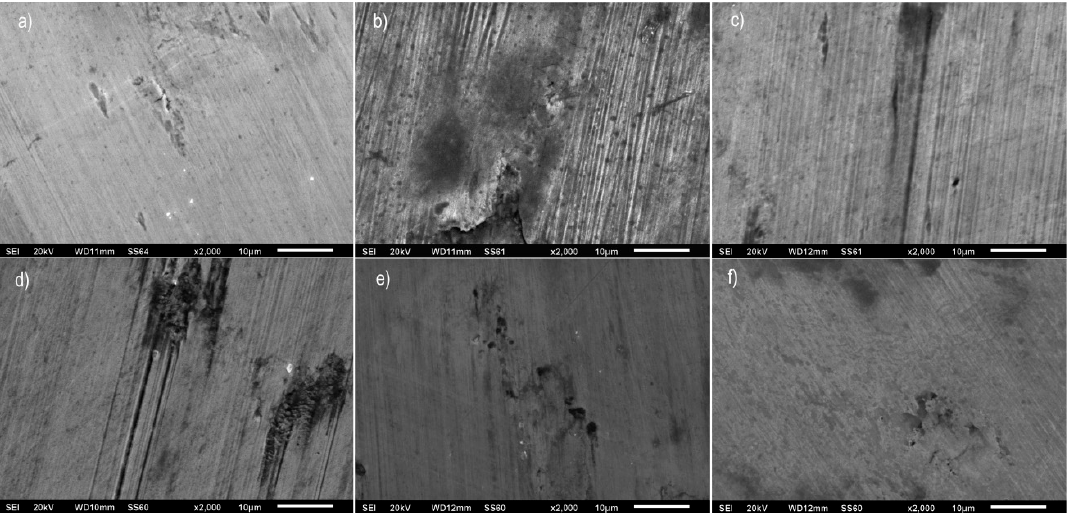
Figure 8. Abrasive wear in: ( a ) 0B-HT 12 km, ( b ) 0.06B-AC 12 km, ( c ) 0.25B-AC 12 km, ( d ) 0.5B-AC 4 km, ( e ) 1B-AC 8 km, ( f ) 1B-HT 8 km.